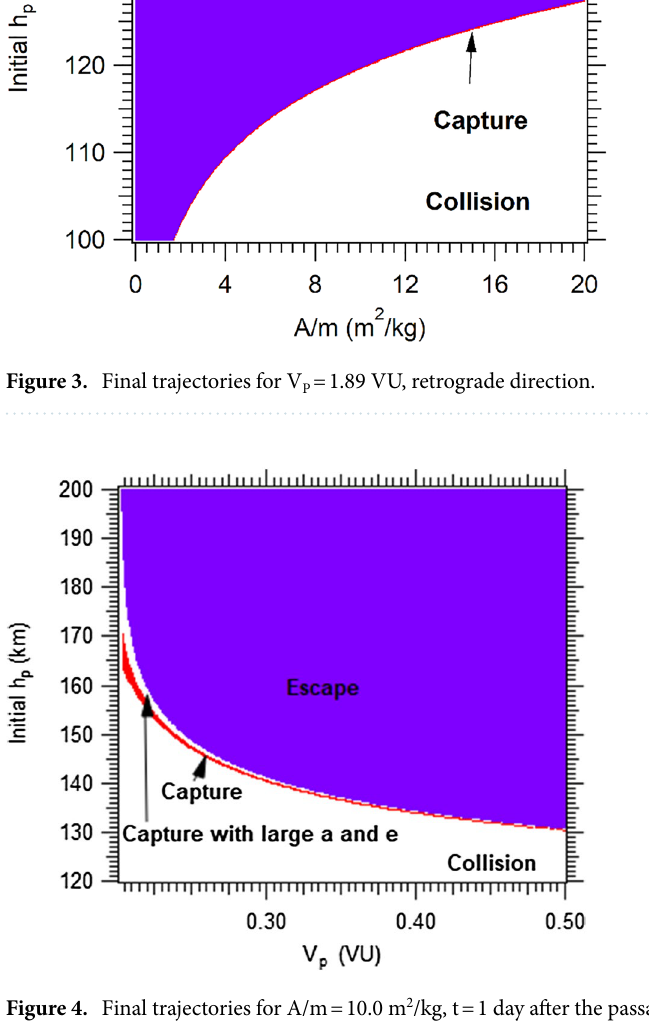
Figure 4. Final trajectories for A/m = 10.0 m 2 /kg, t = 1 day after the